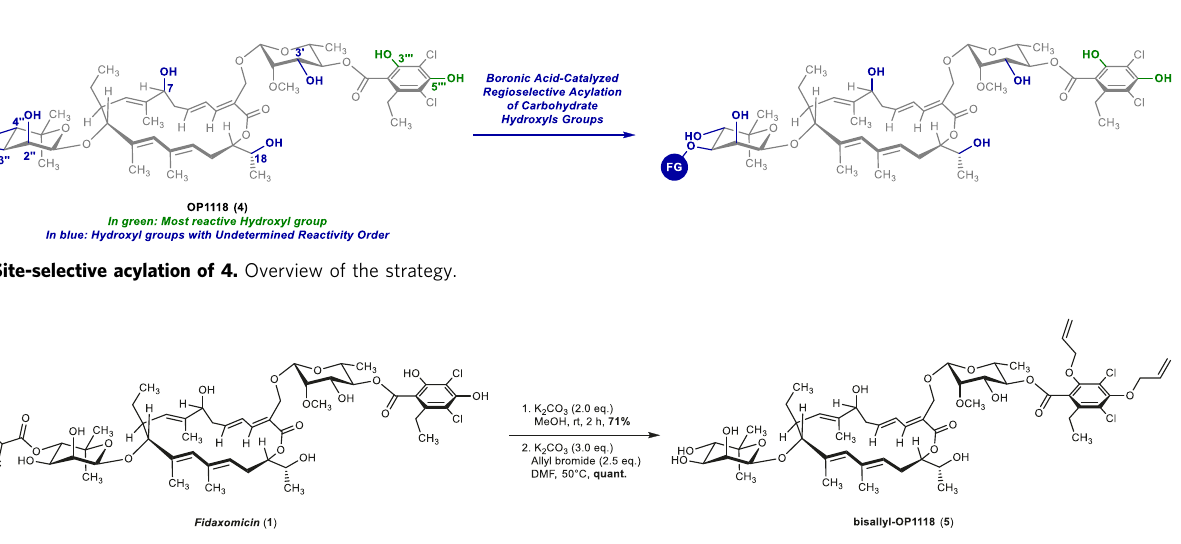
Fig. 5 Preparation of the catalysis-precursor bisallyl-OP1118 (5). Synthesis of 5 from natural product 1 via isobutyl ester hydrolysis and allyl protection.